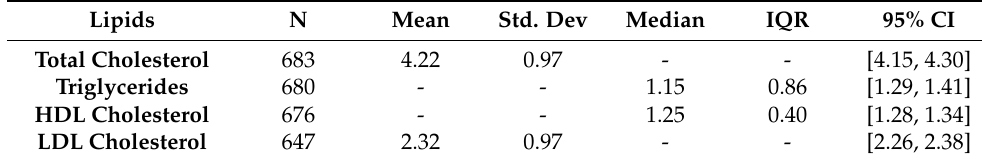
Table 3. lipid profile of the study population. Table 3. Lipid profile of the study population.